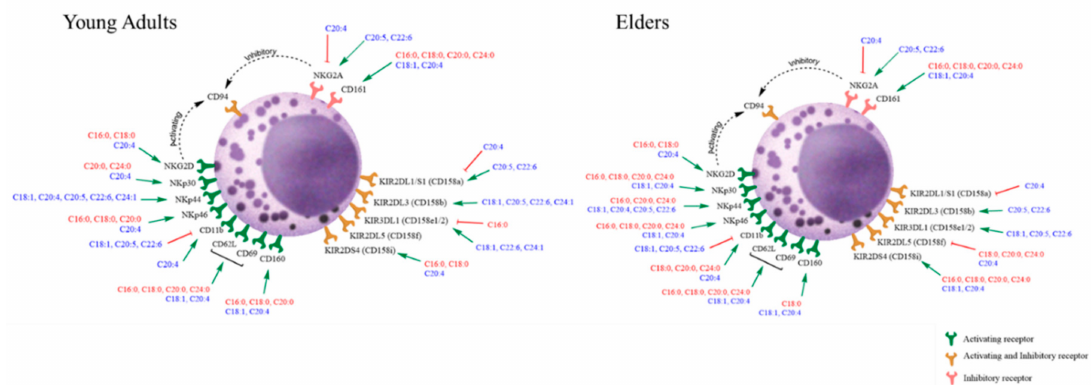
Figure 7. Graphical summary of the e ff ect of fatty acid treatment on NK cell receptors in healthy young adults and elder subjects. The red, bar-headed, arrows indicate a decrease in the expression of receptors on NK cells. The green arrows indicate an increase in receptor expression. Receptors are classified as “activating receptors” in green, “activating and inhibitory receptors” in yellow and “inhibitory receptors” in red. Saturated fatty acids are shown in red. Unsaturated fatty acids are shown in